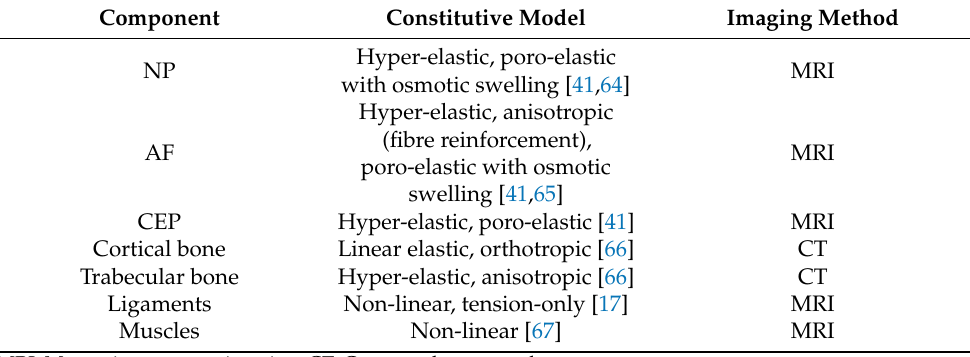
Table 1. Common constitutive modelling options and preferential imaging methods to characterise functional spinal unit (FSU)